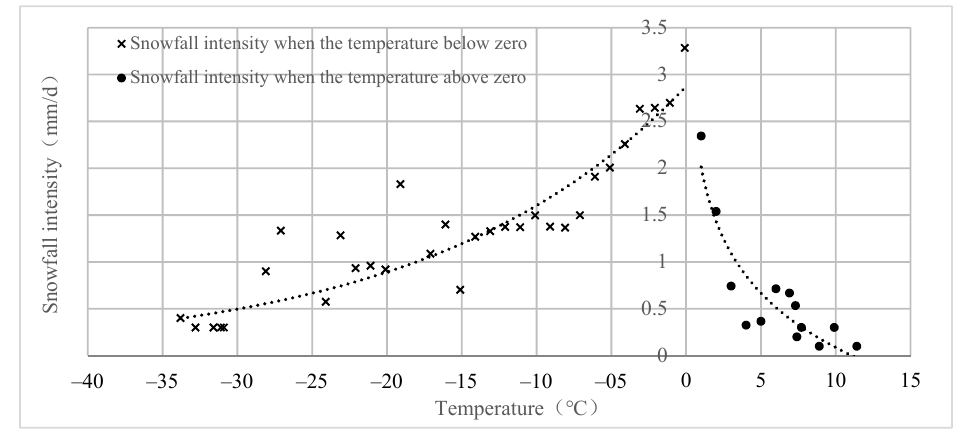
Figure 8. The relationship between the snowfall intensity and temperature.